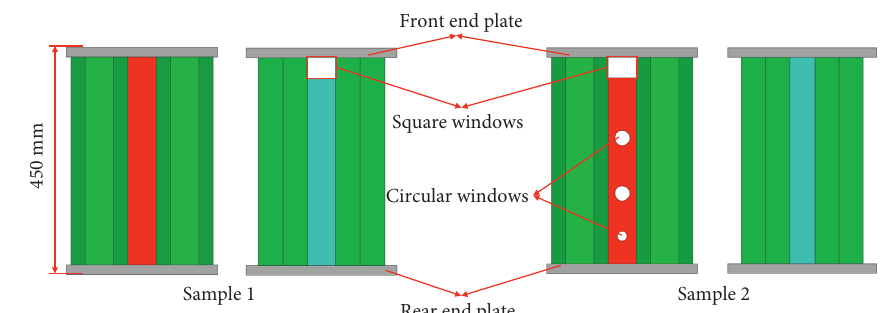
Figure 4: Shapes of the samples used for FEM